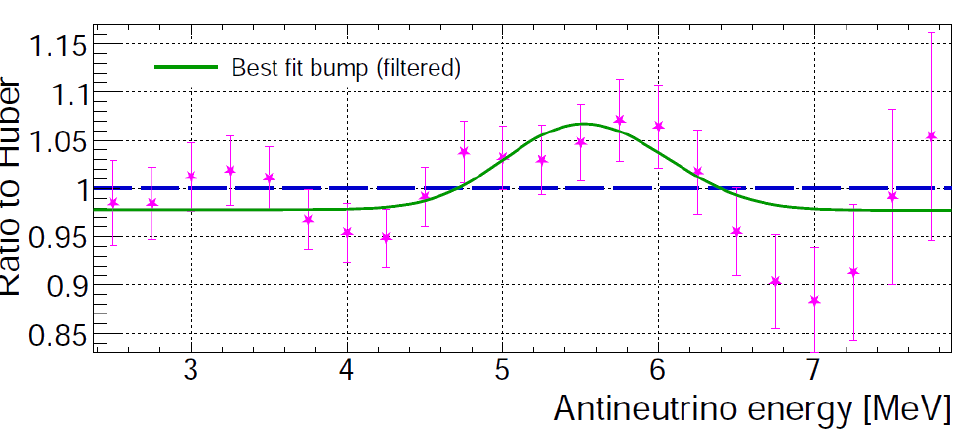
Figure 4. The jointly unfolded 235 U spectrum of the HEU experiments STEREO and PROSPECT relative to Huber’s prediction. The excess around 5MeV is modelled by a Gaussian. Reprinted from [62] under CC BY